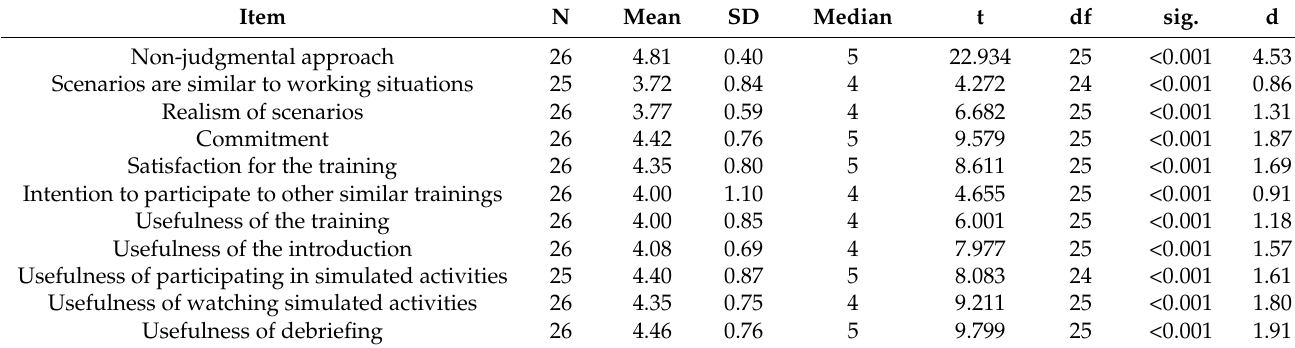
Table 2. Statistics of the items of the post-training feedback